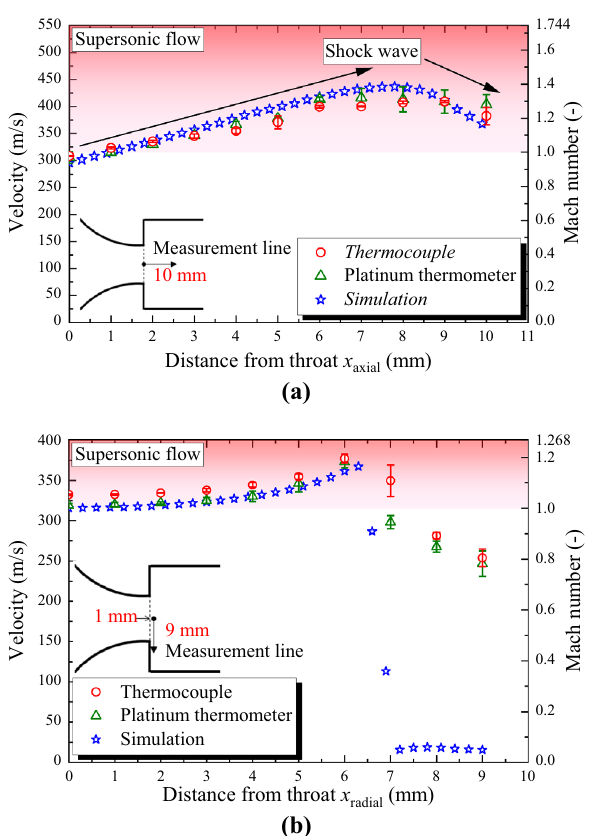
Figure 6. Traverse measurement of flow velocity in a sonic nozzle in the axial and radial directions. The experiments were performed three times under the same conditions. The plots show the mean values and the error bars show the standard errors. The experimental and simulation results were obtained at a back pressure ratio of 0.4. ( a ) Axial velocity distribution from the center of the throat to 10 mm downstream. ( c ) Radial velocity distribution at 1 mm downstream of the throat. The throat radius of the nozzle is approximately 6.7